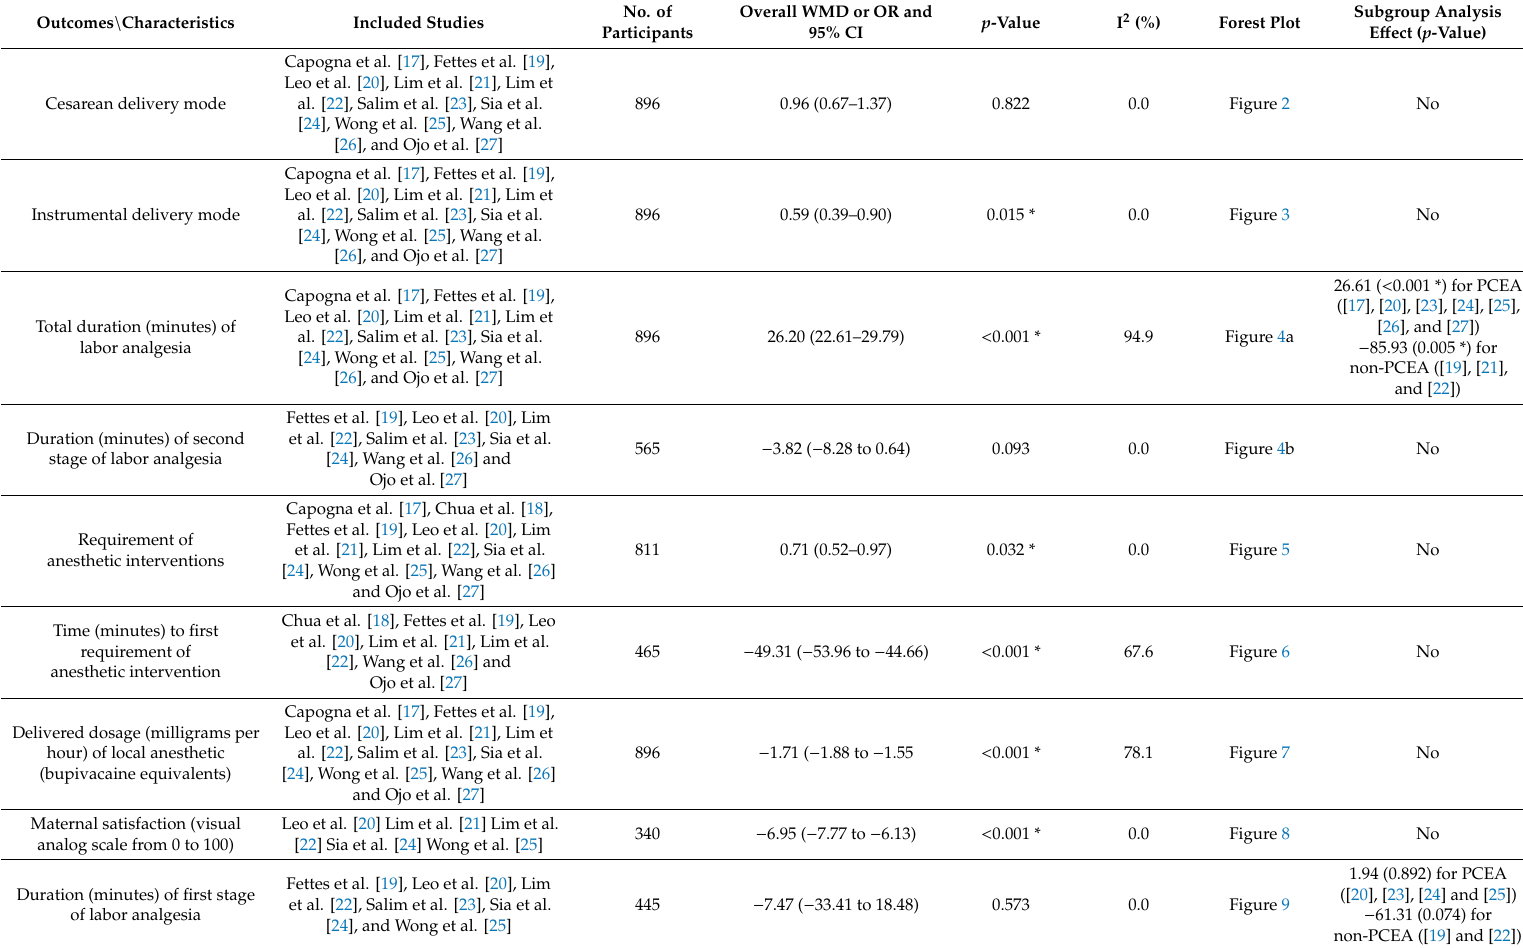
Table 1. Summary of general characteristics and results of pooled outcomes based on eligible